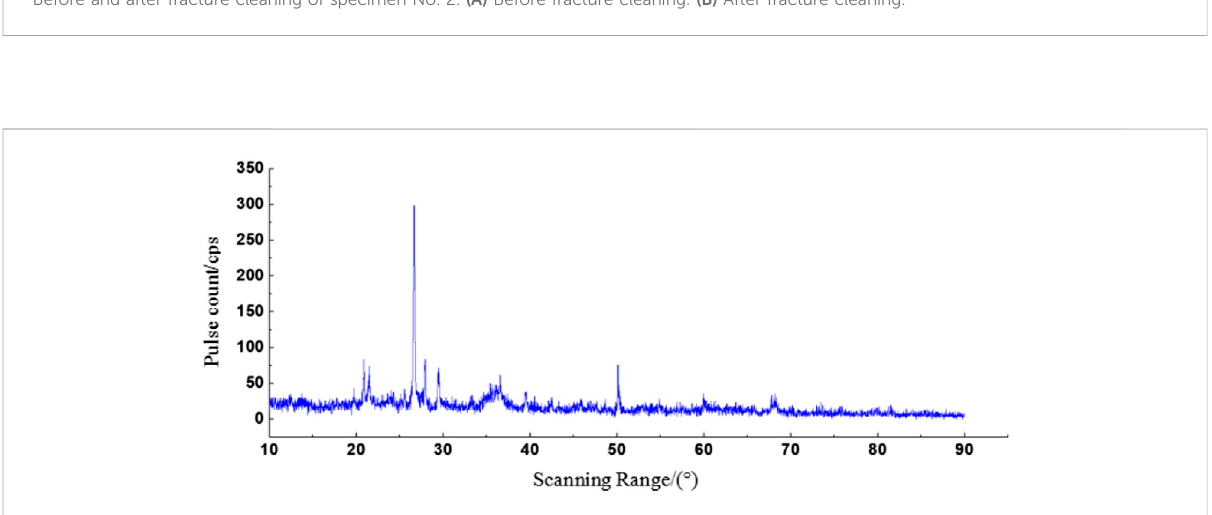
FIGURE 5 Before and after fracture cleaning of specimen No. 2. (A) Before fracture cleaning. (B) After fracture cleaning.